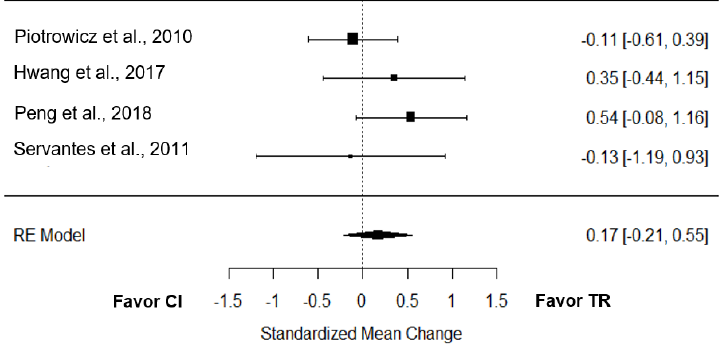
Figure 6. Effect of TR on QoL compared to CI [19,21,25,27].